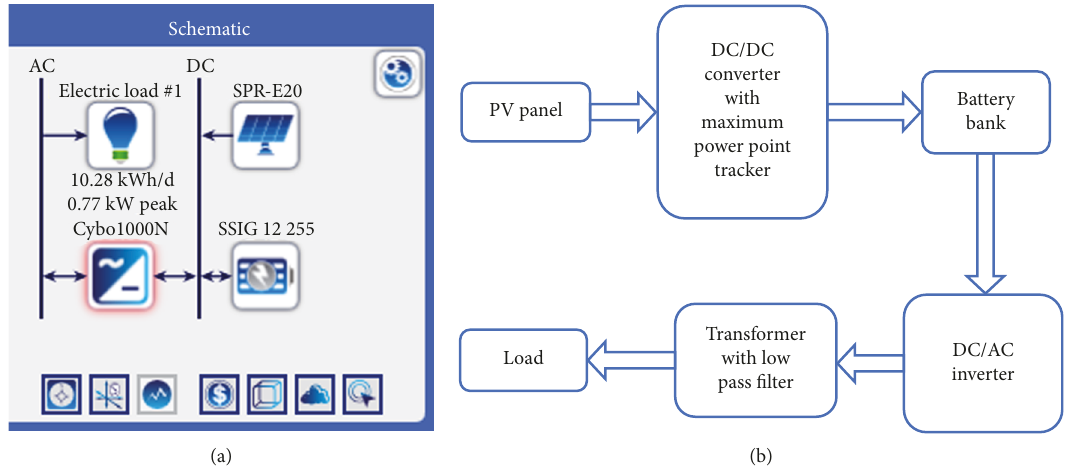
Figure 6: (a) System structure with integrated subblocks. (b) Flow chart of the system structure with subblocks followed in Simulink